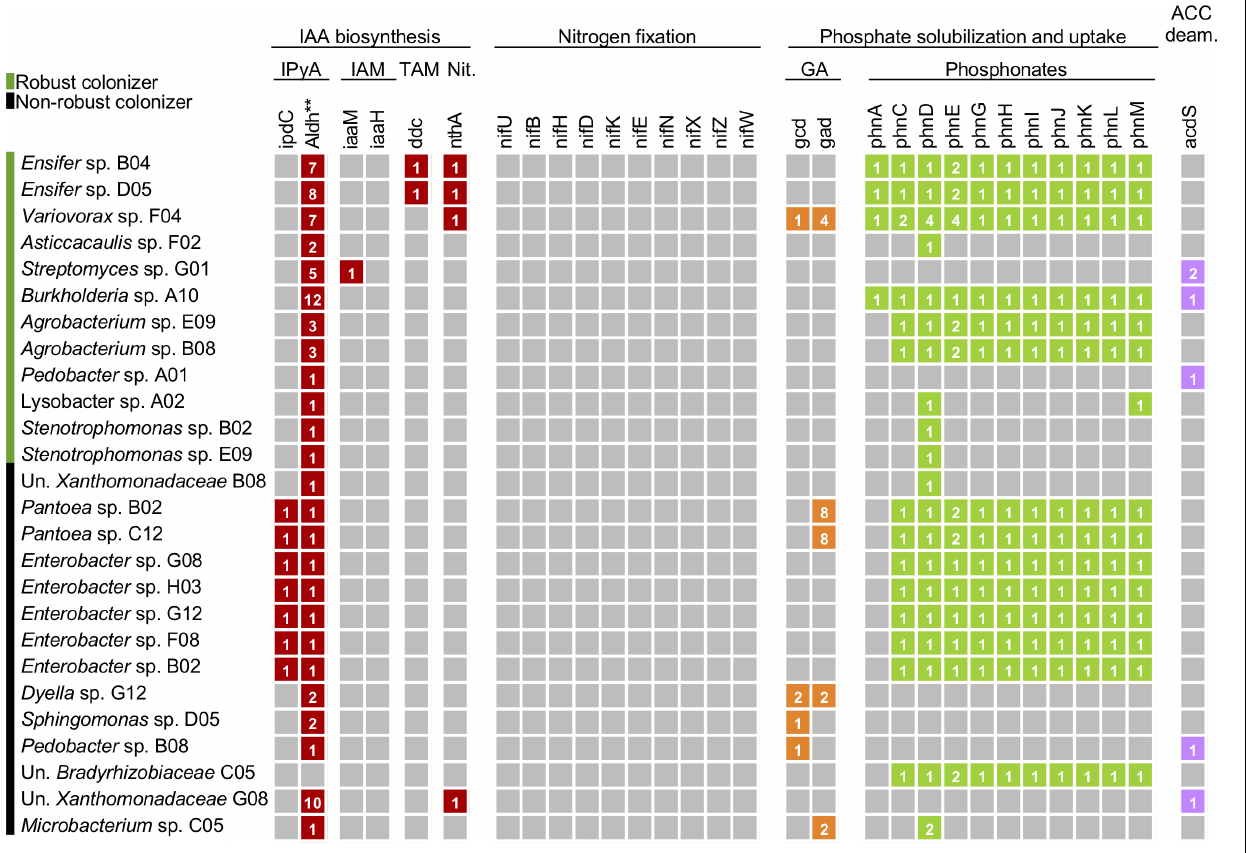
FIGURE 3 | Commonly investigated plant growth-promoting features in plant-associated bacteria are not deterministic of colonization lifestyle. Genomes were surveyed for minimal gene cassettes involved in the biosynthetic pathway of common plant growth-promoting features in bacteria such as indole-3-acetic acid (IAA) production, N fixation, phosphate solubilization and uptake, and ACC deaminase activity. Each column represents a gene of a pathway. The numbers inside colored boxes represent gene copies within a genome. Absence of genes is represented by gray boxes. For IAA production, a total of four different biosynthetic pathways were surveyed (IPyA, IAM, TAM, and nitrilase). Un., Unknown; Nit., Nitrilase; GA, gluconic acid; ACC deam., 1-aminocyclopropane-1-carboxylic acid (ACC) deaminase. Statistical differences in copy number of genes between robust and non-robust colonizer were compared using Student’s t -test ( ∗∗ p -value ≤